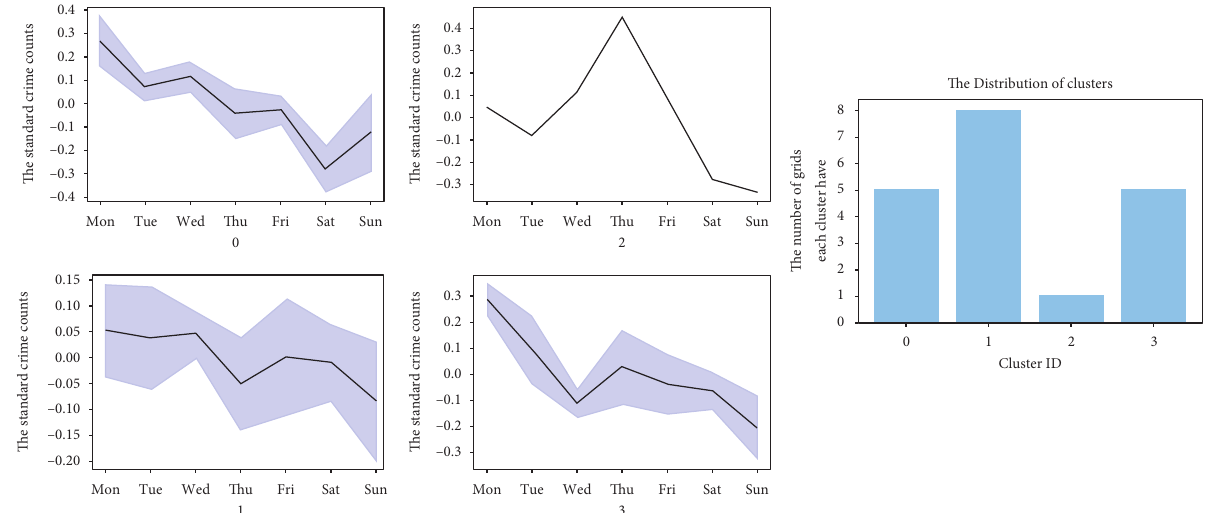
Figure 18: The burglary in Philadelphia trends in the average week in 2018 and the distribution of clusters. The line charts are the weekly trends of burglary in Philadelphia in 2018. The bar chart is the distribution of the